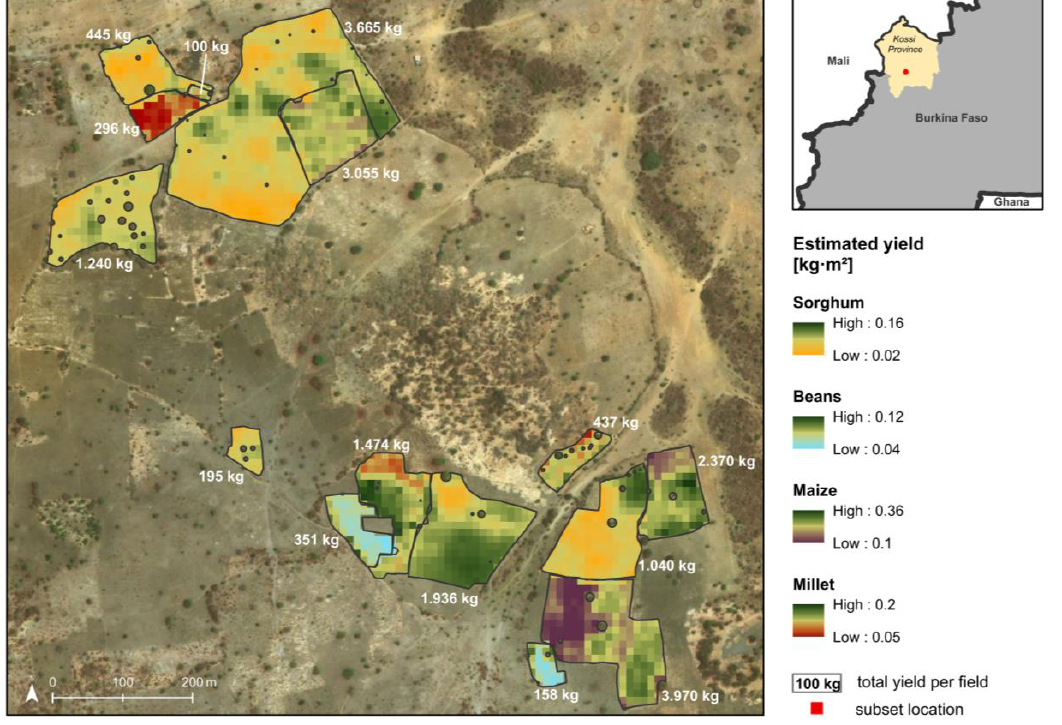
Figure 3. Subset of the study area with modelled yield amounts per crop-type (kg·25 m − ²) and the total amount of yield per field. Locator shows Kossi province in Burkina Faso. Basemap: ESRI.